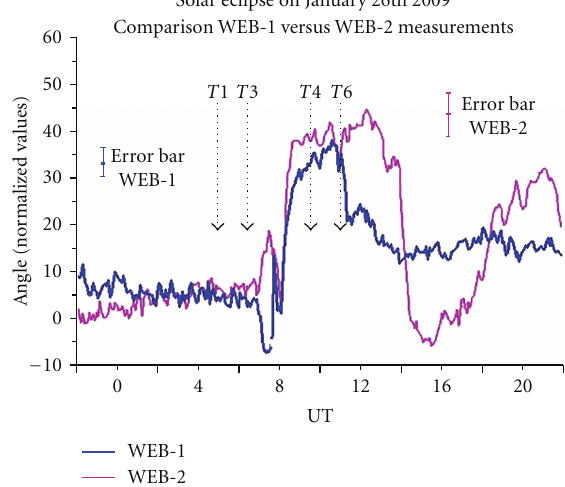
Figure 4: Comparison of the “pure” results obtained with WEB-1 and WEB-2 devices on